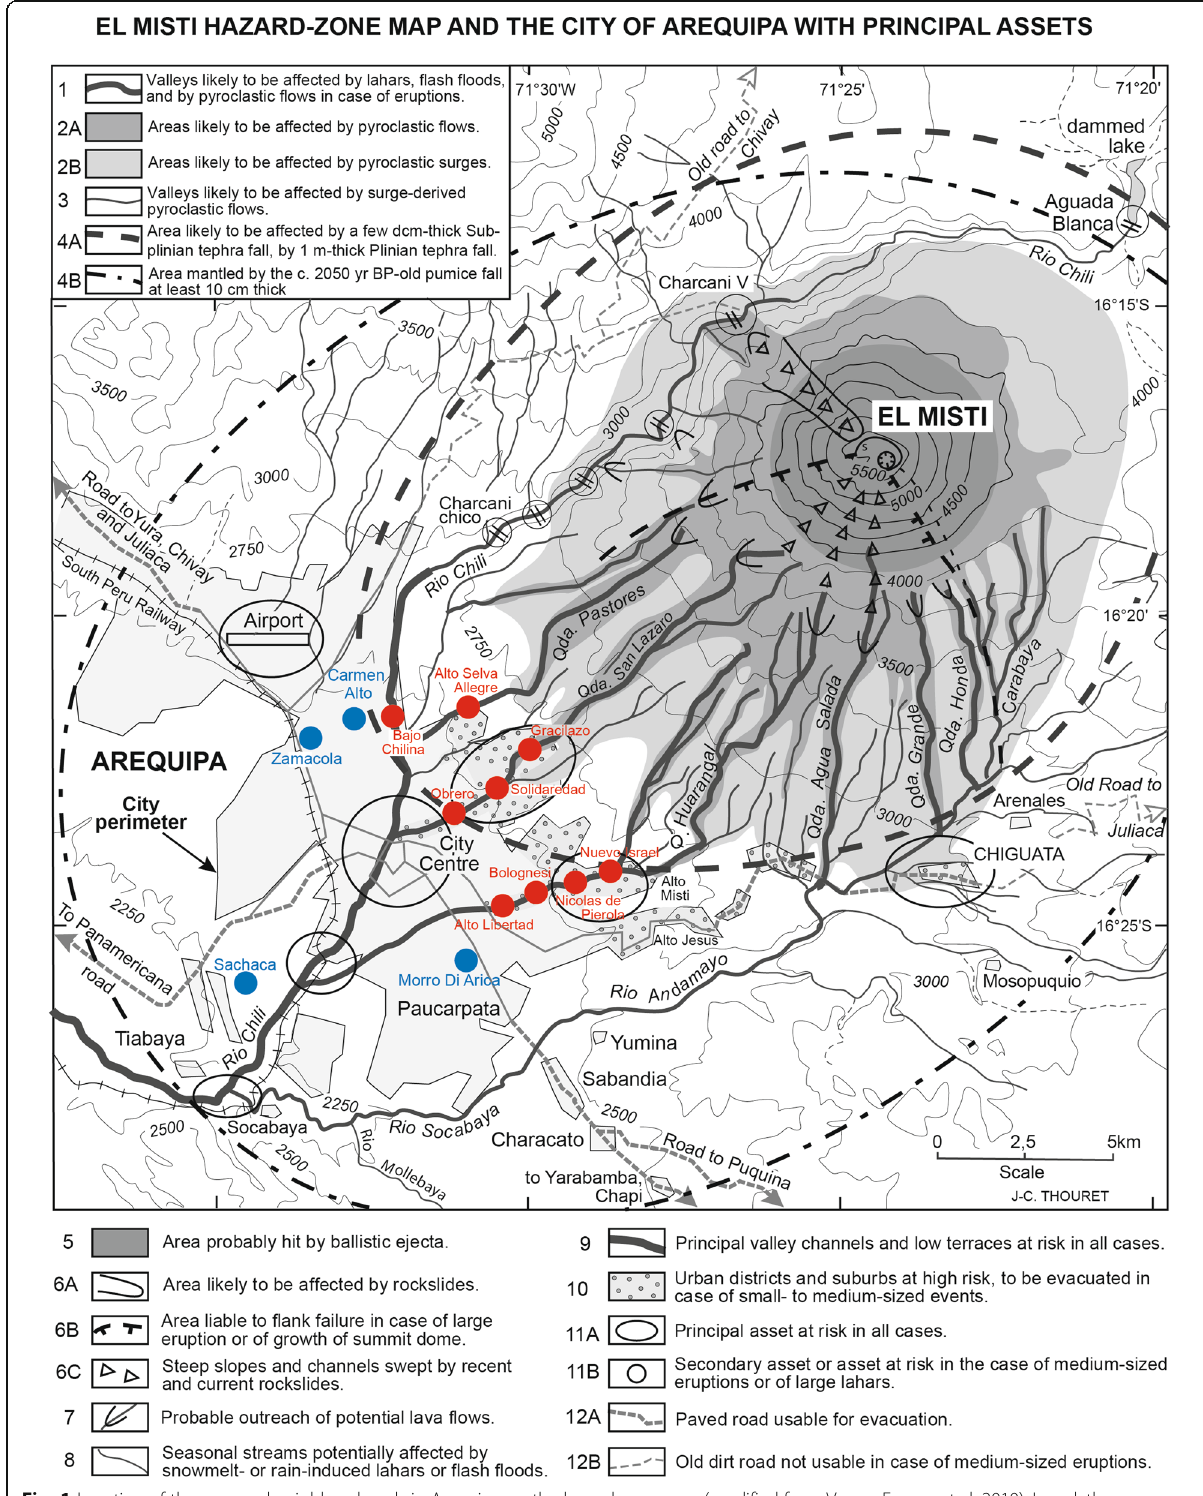
Fig. 1 Location of the surveyed neighbourhoods in Arequipa on the hazard zone map (modified from Vargas Franco et al. 2010). In red, the neighbourhoods exposed to lahars/in blue, the neighbourhoods not exposed to lahars. Notes of caution: The entire area enclosed in the map is liable to tephra fall a few centimeters thick in case of Plinian eruptions, The map integrates seasonal variations of prevailing winds. The distribution of tephra therefore may vary from this